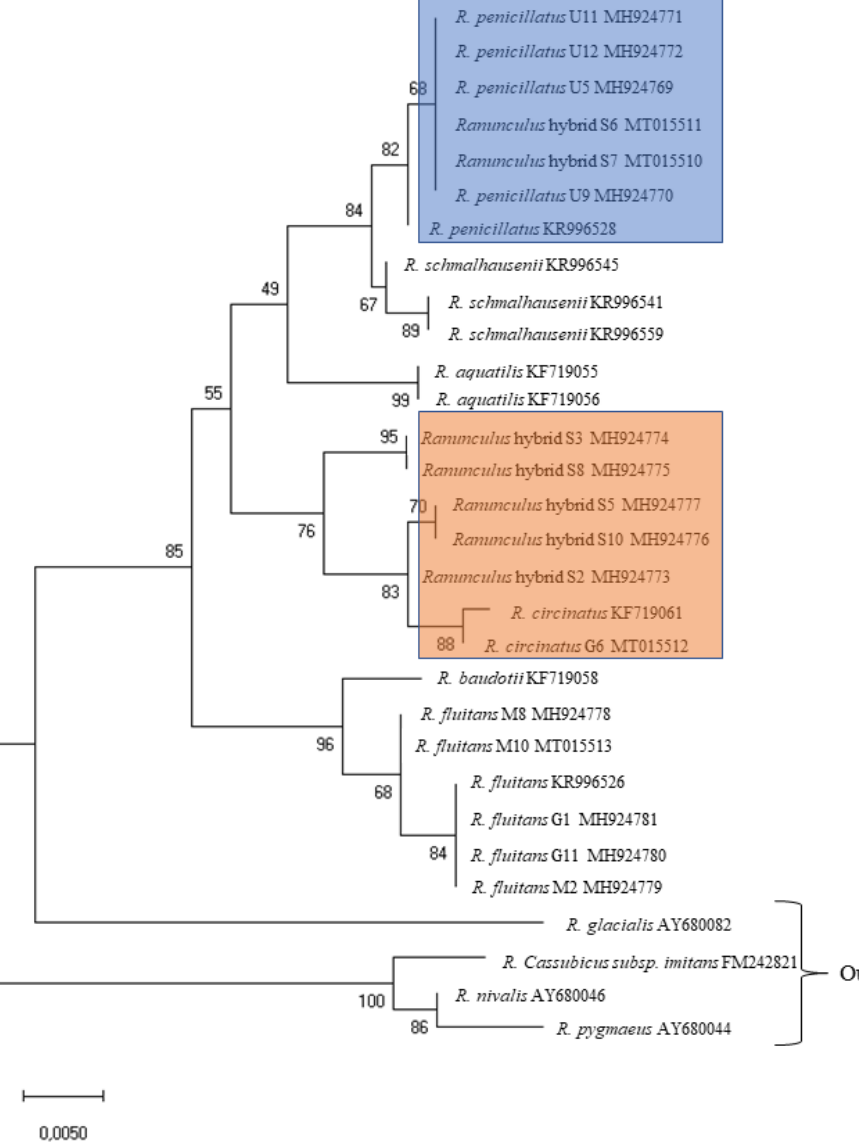
Figure 1. The ITS tree built using the maximum likelihood (ML) method showing relationships between 30 accessions of Ranunculus sect. Batrachium . Numbers indicate support values of ML analysis. Bootstrap support values were computed for 1000 replicates. The blue cluster combines R. penicillatus from the Ula River and Ranunculus hybrid sequences from the Skroblus River with the same ribotype of R. penicillatus ; the orange cluster combines R. circinatus from the Gruda River and Ranunculus hybrid sequences from the Skroblus River with the same or very similar ribotypes of R. circinatus KF719061.